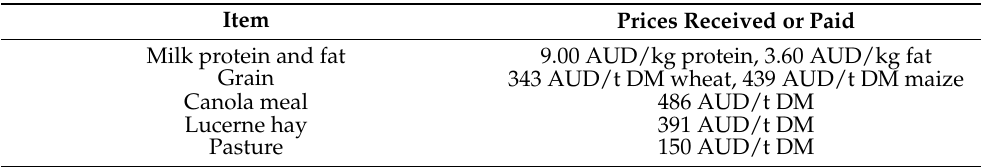
Table 1. Milk prices and feed prices used in the economic analysis (in AUD; average exchange rate at the time of analysis: AUD 1 = USD